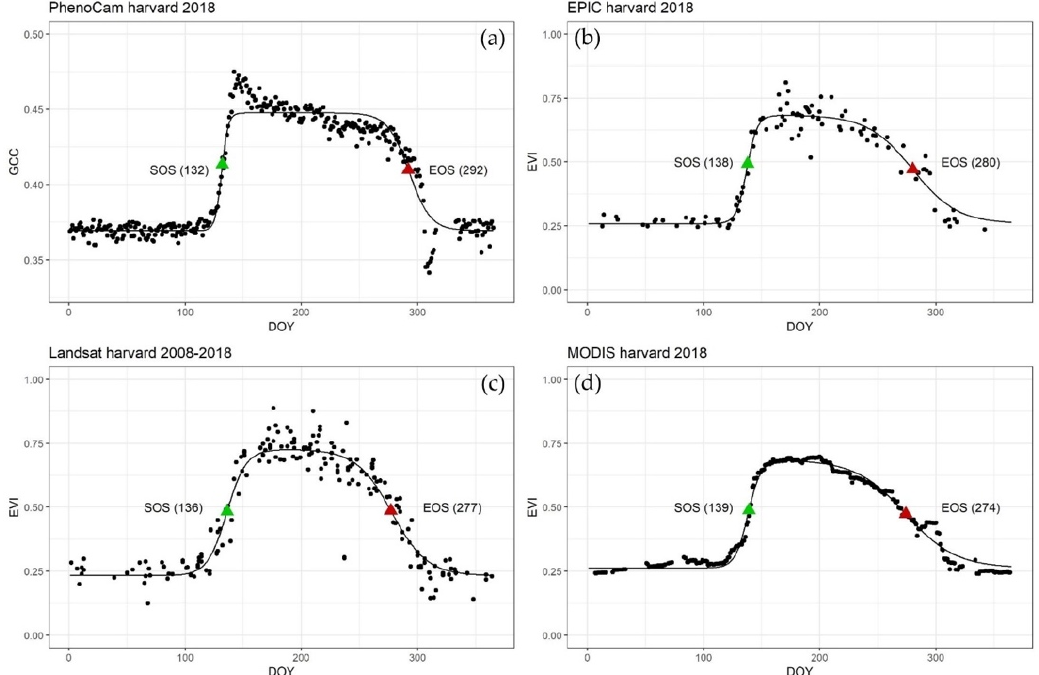
Figure 4. Derived vegetation phenology indicators of SOS and EOS from EVI for Harvard Forest (harvard) study site (deciduous broadleaf), based on ( a ) PhenoCam, ( b ) EPIC, ( c ) Landsat, and ( d ) MODIS observations. The green triangles represent SOS, and the red triangles represent EOS for each vegetation type and dataset. The y-axis scale was kept constant for Landsat, MODIS, and EPIC, but amplified for PhenoCam for better illustration of the shape of the curve. Additional figures for the remaining five land cover types are in Appendix A.